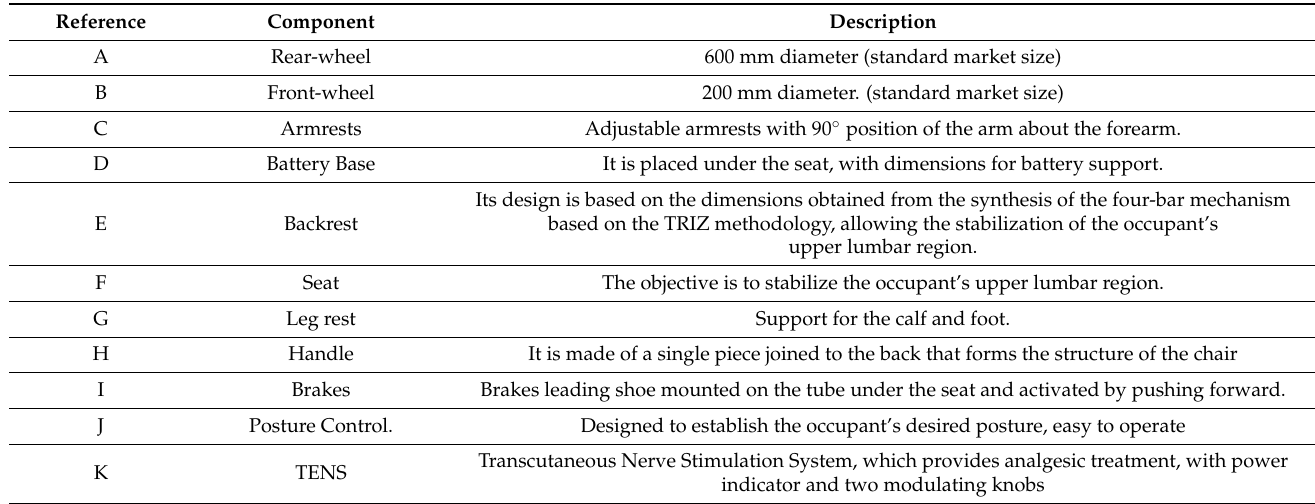
Table 1. Wheelchair components description.